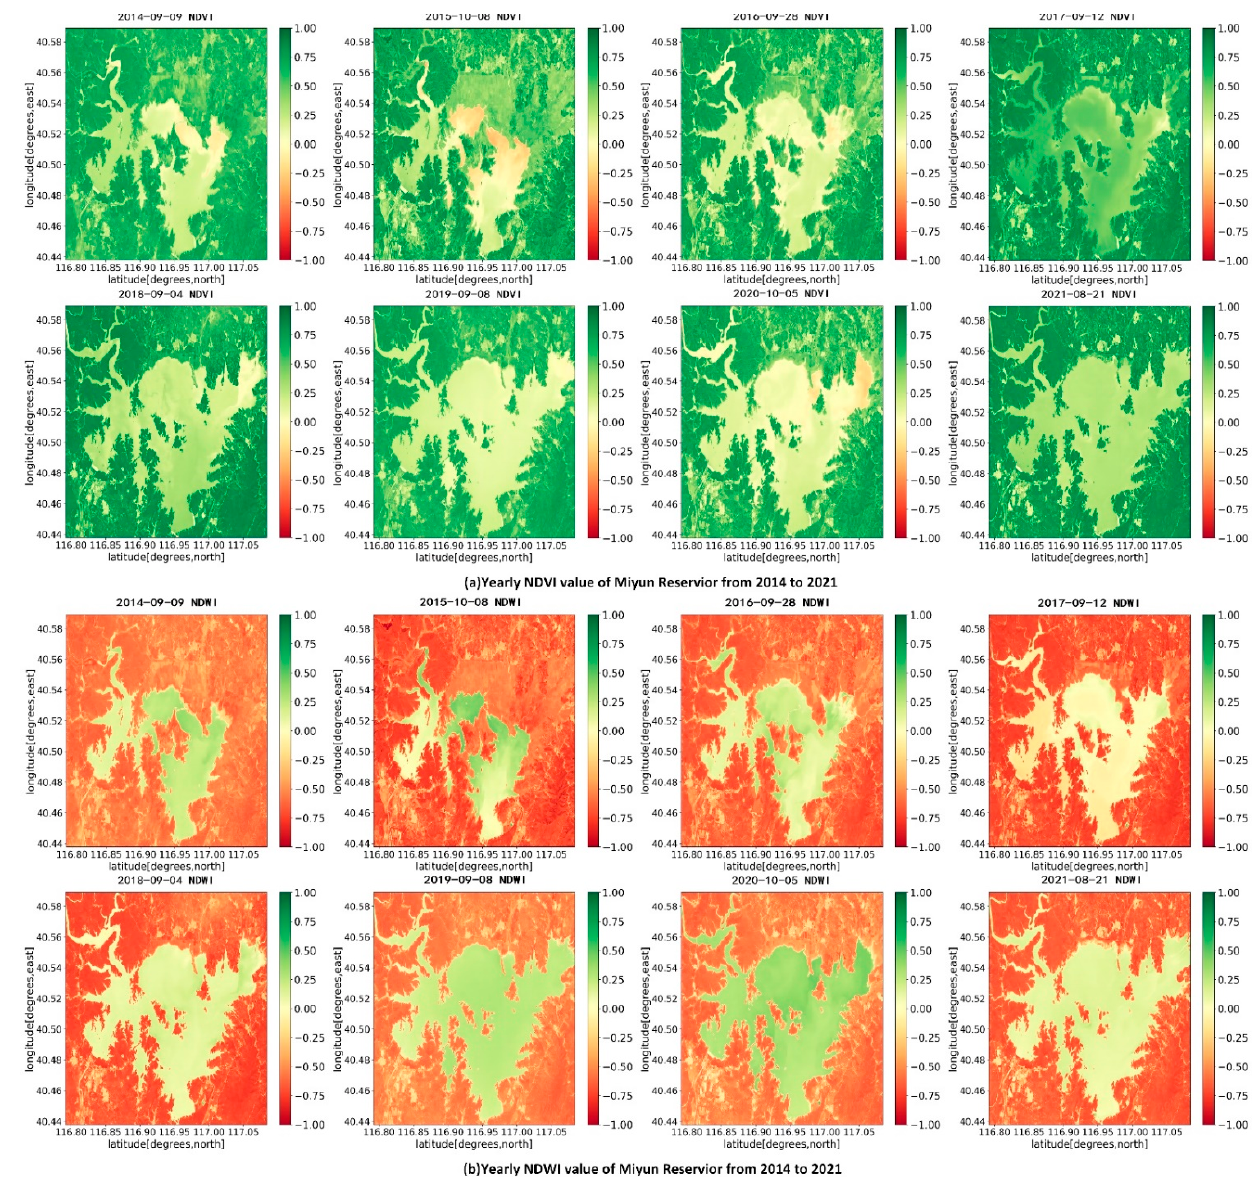
Figure 8. Spatial distribution of NDVI and NDWI in and around the Miyun Reservoir from 2014 to 2021.